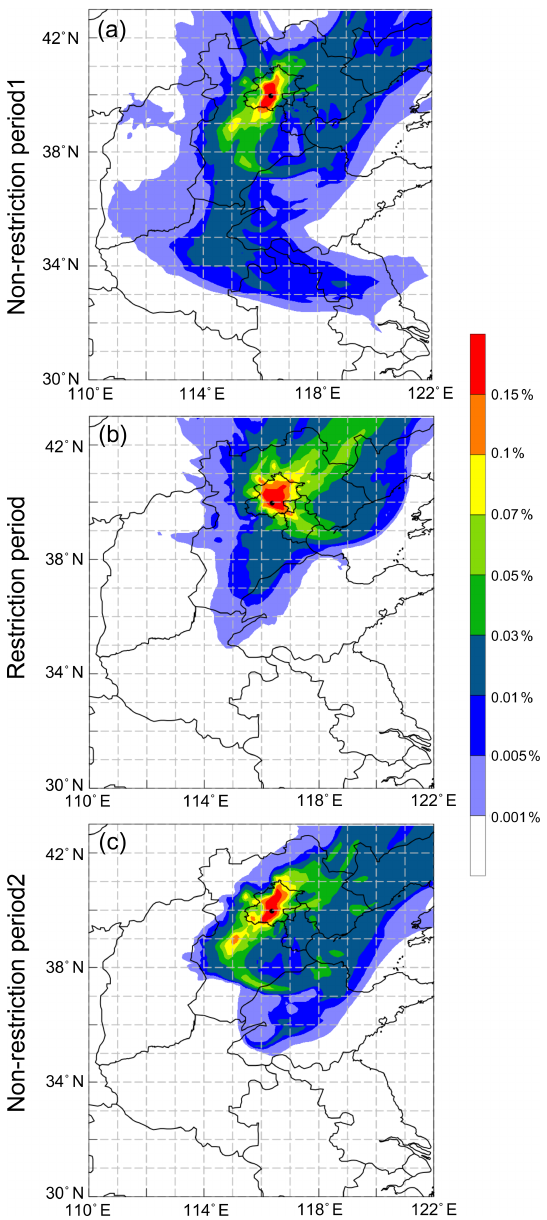
Figure 5. Aerosol footprint regions of the non-restriction and re- striction periods. The colour bar indicates the relative residence time of tracer particles, and the black dot represents the sampling site.